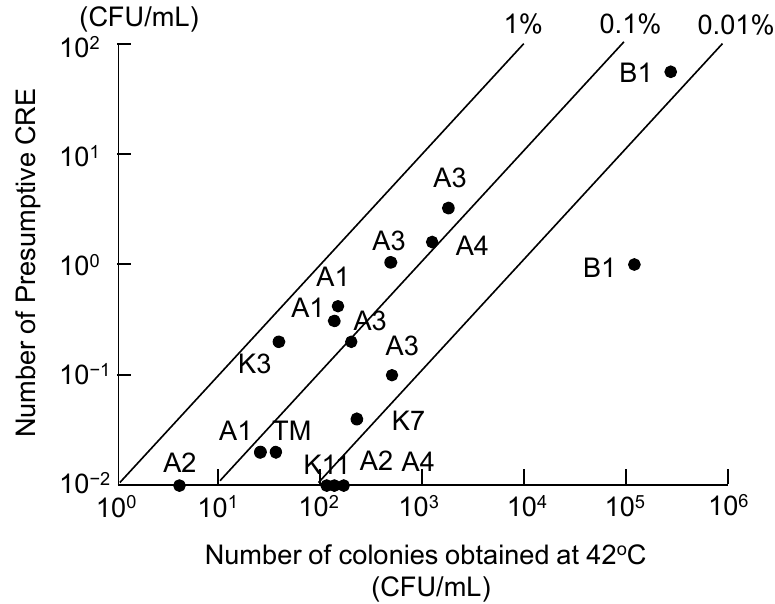
Figure 1. Number of colonies on the plates incubated at 42 °C. Presumptive CRE were also counted from the colonies on plates containing meropenem.